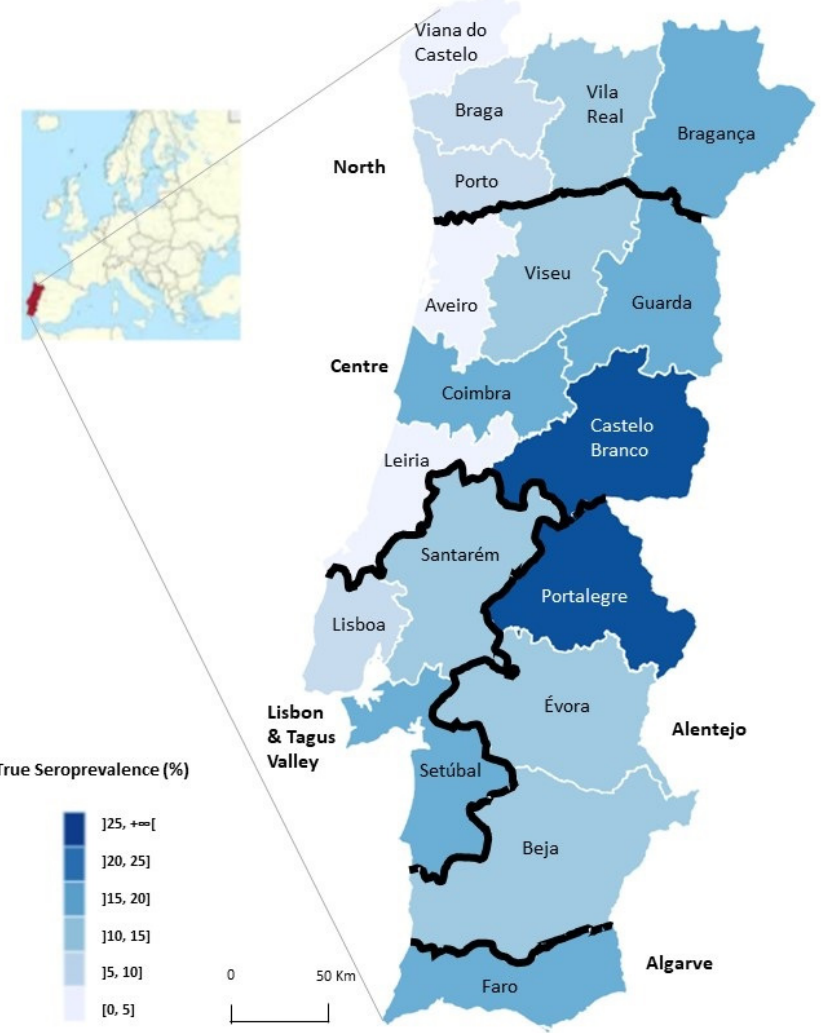
Figure 1. Map of continental Portugal showing a categorical representation of true seroprevalence for Leishmania infection in dogs determined by DAT, per district and NUTS2. (Map draw in mapinseconds.com (accessed on 16 October 2022)). Table 1. Number of enrolled veterinary clinics, and seroprevalence by region (NUTS2) / district of the whole sample set.